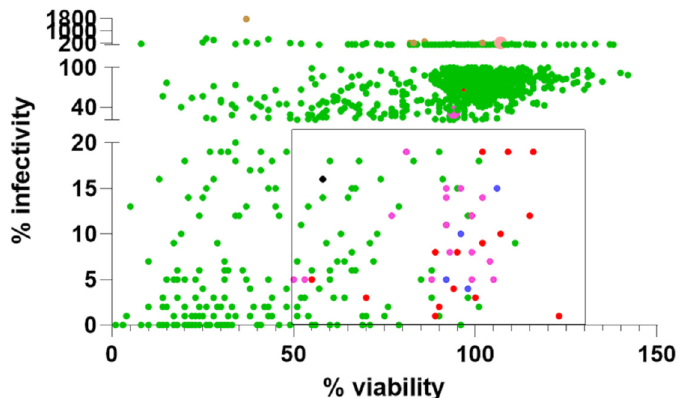
Figure 1. Kite-shaped molecules predominates drug hits. A scatter plot of % infectivity versus % viability in two library screens against SARS-CoV-2 spike protein pseudovirus infection of 293T-ACE2 cells. Individual data are represented by green dots. Ninety-eight drugs within the square ( ≤ 20% infectivity; ≥ 50% viability) were negative screened against VSV-G pseudovirus apart from the one represented by a black dot. Drug hits specific for SARS-CoV-2 spike pseudovirus are represented by red dots, with kite-shaped molecules represented by violet dots and kite-like-shaped molecules represented by blue dots. Imipramine fell outside the range of the square in the library screen (represented by an enlarged violet dot) but displayed a higher inhibitory effect in the focused kite- shaped molecules screen to make the top hits (see Table S3). Some drug hits displayed varied viability. Select drugs showing ≥ 200% of SARS-CoV-2 pseudovirus infectivity were also negative screened against VSV-G pseudovirus (represented by brown dots) and tazarotene was found to be a true potentiator specific for SARS-CoV-2 spike pseudovirus and is represented by an enlarged pink dot. Some dots overlap.